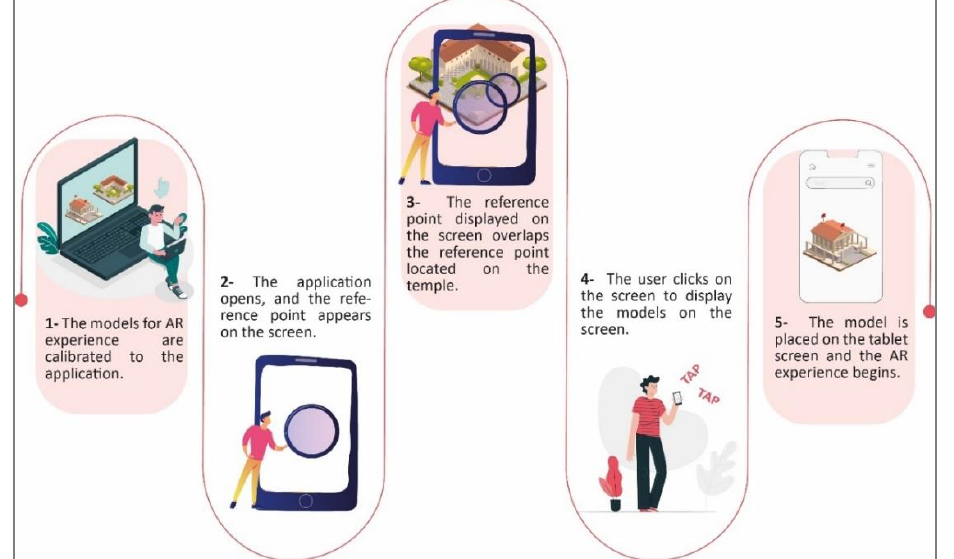
Figure 14 Calibration and Click-gestures of